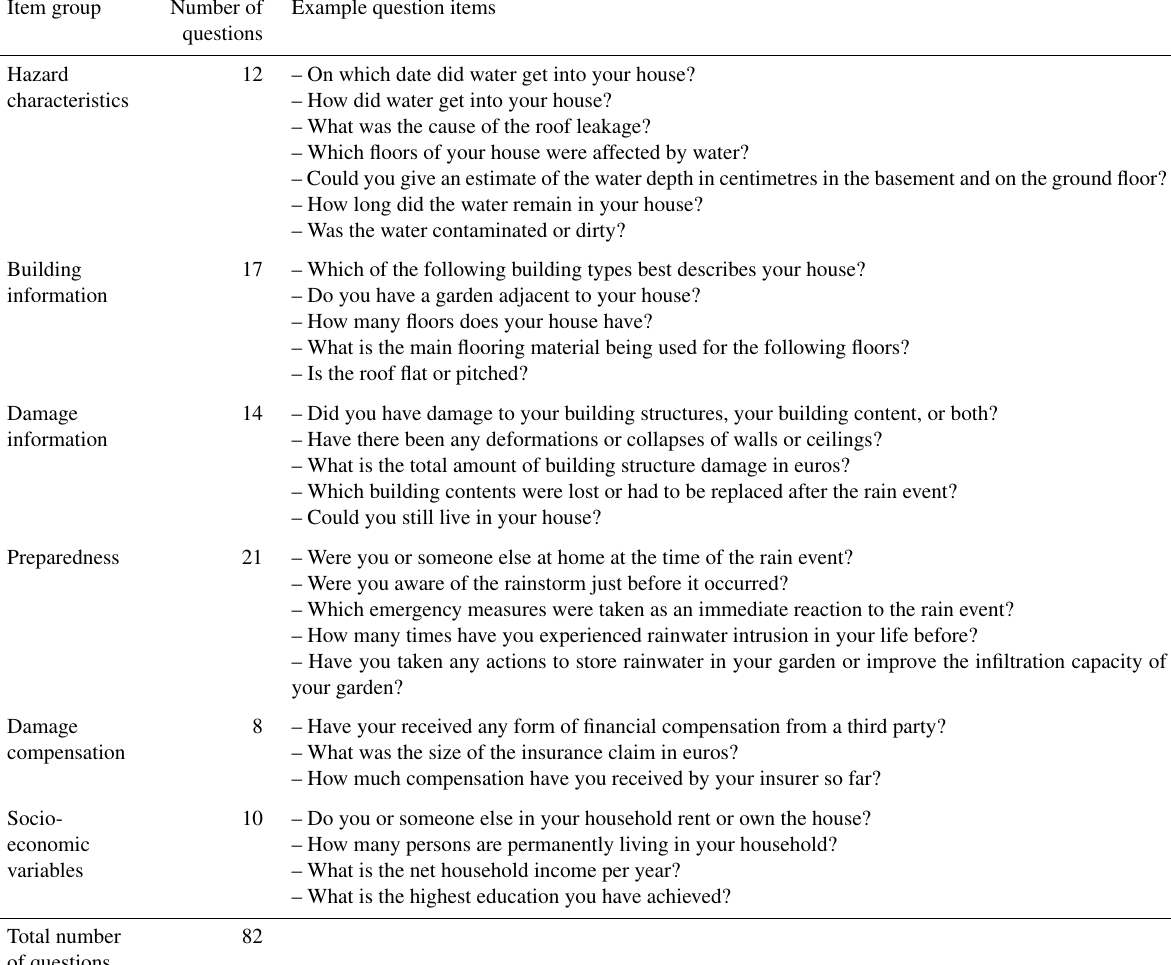
Table A1. Questionnaire: item groups and example question items Item group Number